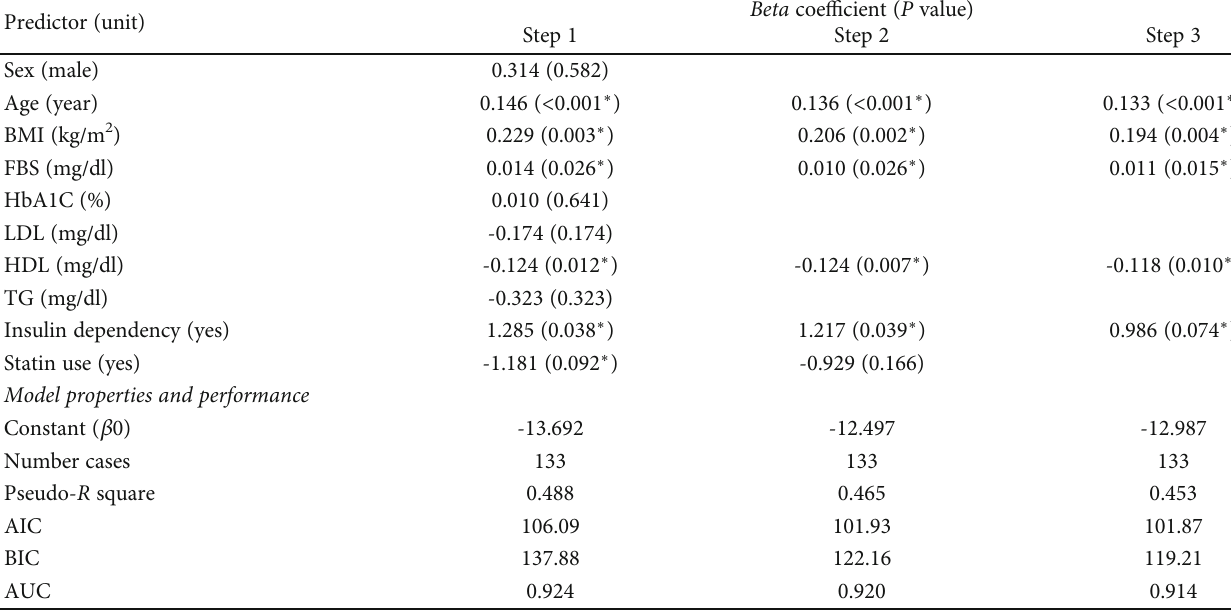
Table 1: Logistic regression modeling for prediction of diabetic foot